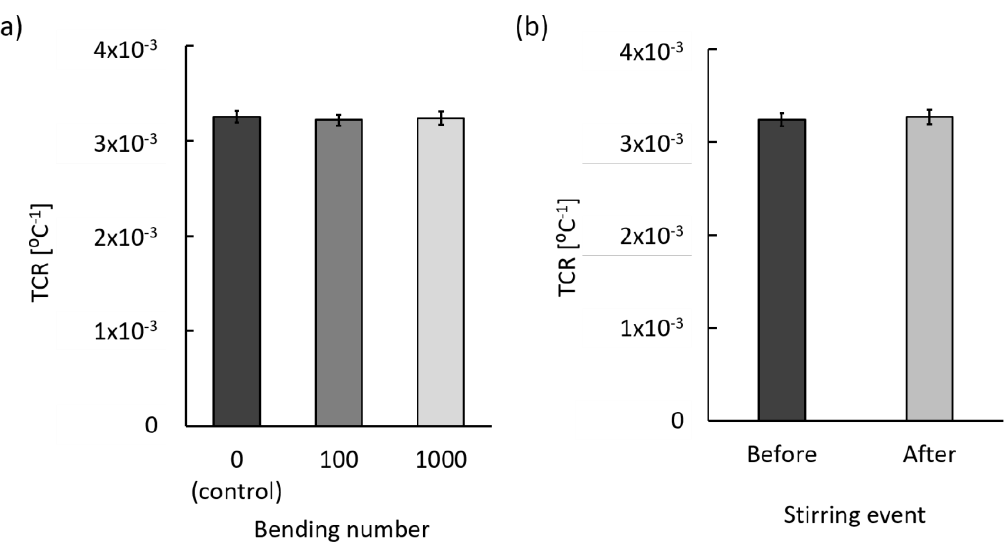
Figure 8. Stable mechanical properties before and after the mechanical stress test: ( a ) 180° bending test for 1000 times (N = 9) and ( b ) stirring test for 30 min (N = 6). Error bars represent the SD.